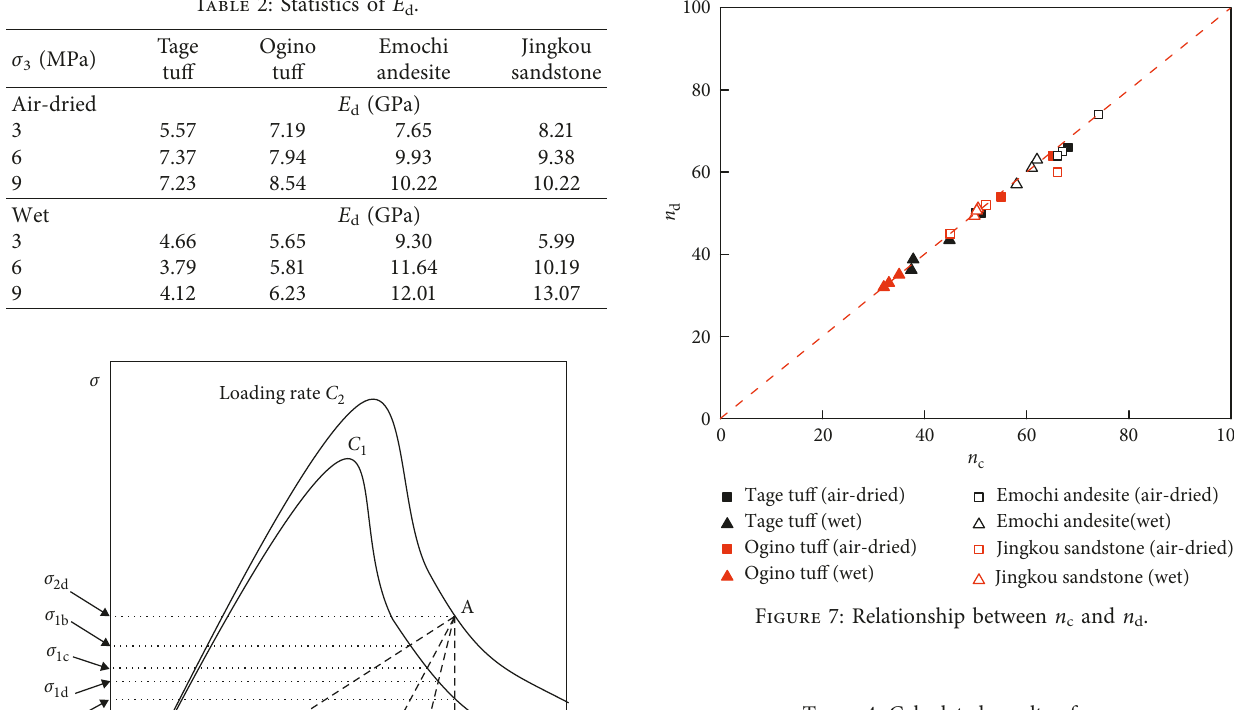
Table 2: Statistics of E